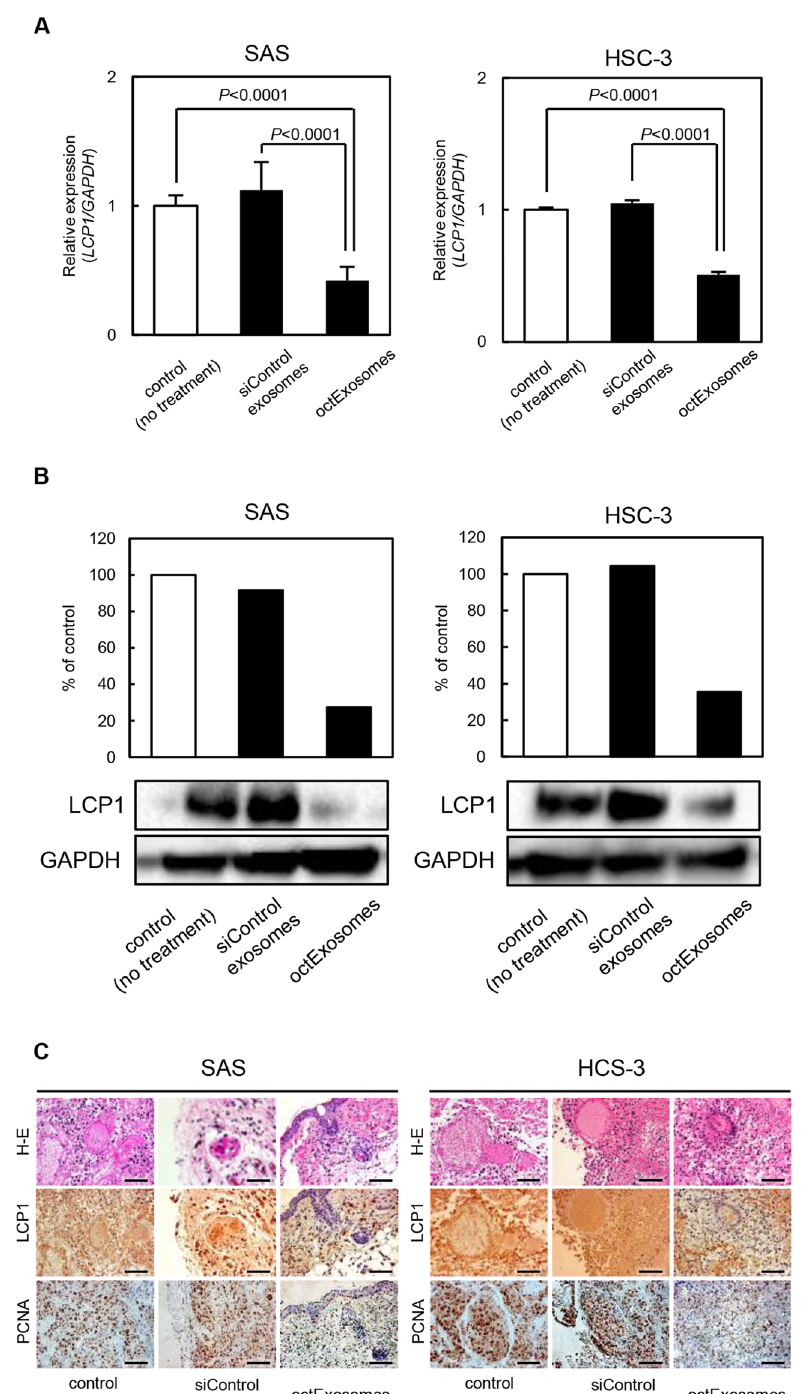
Figure 6. Tumor xenograft studies after i.v. injections of exosomes. ( A ) Quantitation of LCP1 mRNA change. (Data are presented as means ± SD. N = 5. * P < 0.05.) ( B ) Quantitation of LCP1 protein change. A, B. Based on qPCR and Western blot analyses. Note that LCP1 was considerably suppressed in the octExosome group compared to siControl exosome and control groups at both the mRNA level and protein level. ( C ) Immunohistochemical analysis of tumor LCP1 and PCNA changes. LCP1 and PCNA expressions were considerably suppressed in the octExosome group. Scale bars indicate 50